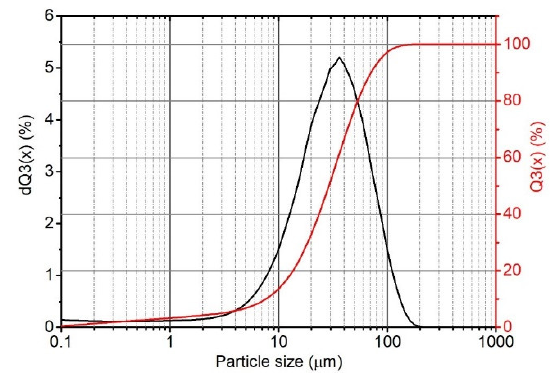
Figure 2. TG thermogram of ES filler in nitrogen.